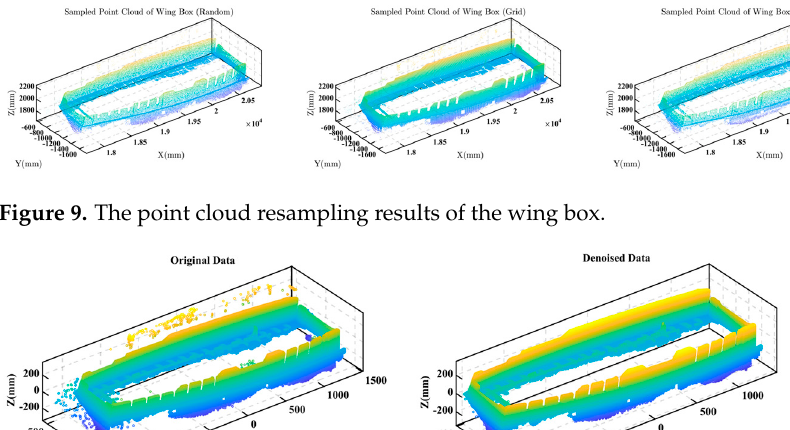
Figure 8. Original point cloud data of the wing box.